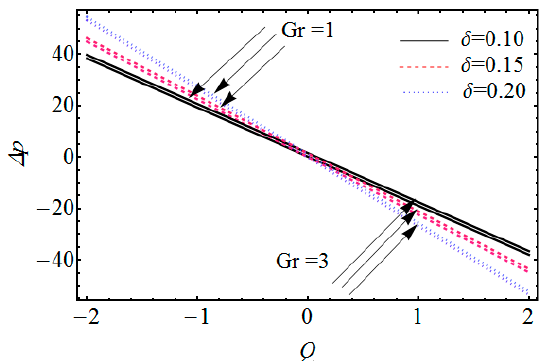
Figure 5. Variation of pressure rise ∆ p with δ and Gr for fixed θ = 0.8, ϕ = 0.1, ε = 0.1, Br = 0.2, Nb = 0.5, Nt = 0.2, λ 1 = 5, V = 0.1, t = 0.05.